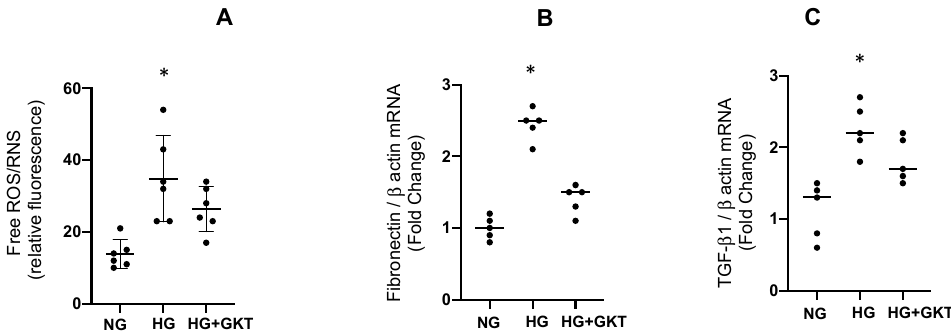
Figure 9. ROS, mRNA expression of fibronectin and TGF- β 1 in mouse M1 collecting duct cell line treated with high glucose (HG) with or without GKT 137831 (GKT) treatment. ( A ) Effect of NOX-4 inhibition on ROS generation and transcript levels of fibronectin ( B ) and TGF- β 1 ( C ) in M-1 collecting duct cell line. GKT 137831 partially blunted ROS induction and increased mRNA levels of fibronectin and TGF- β 1. * p < 0.05, n = 6.